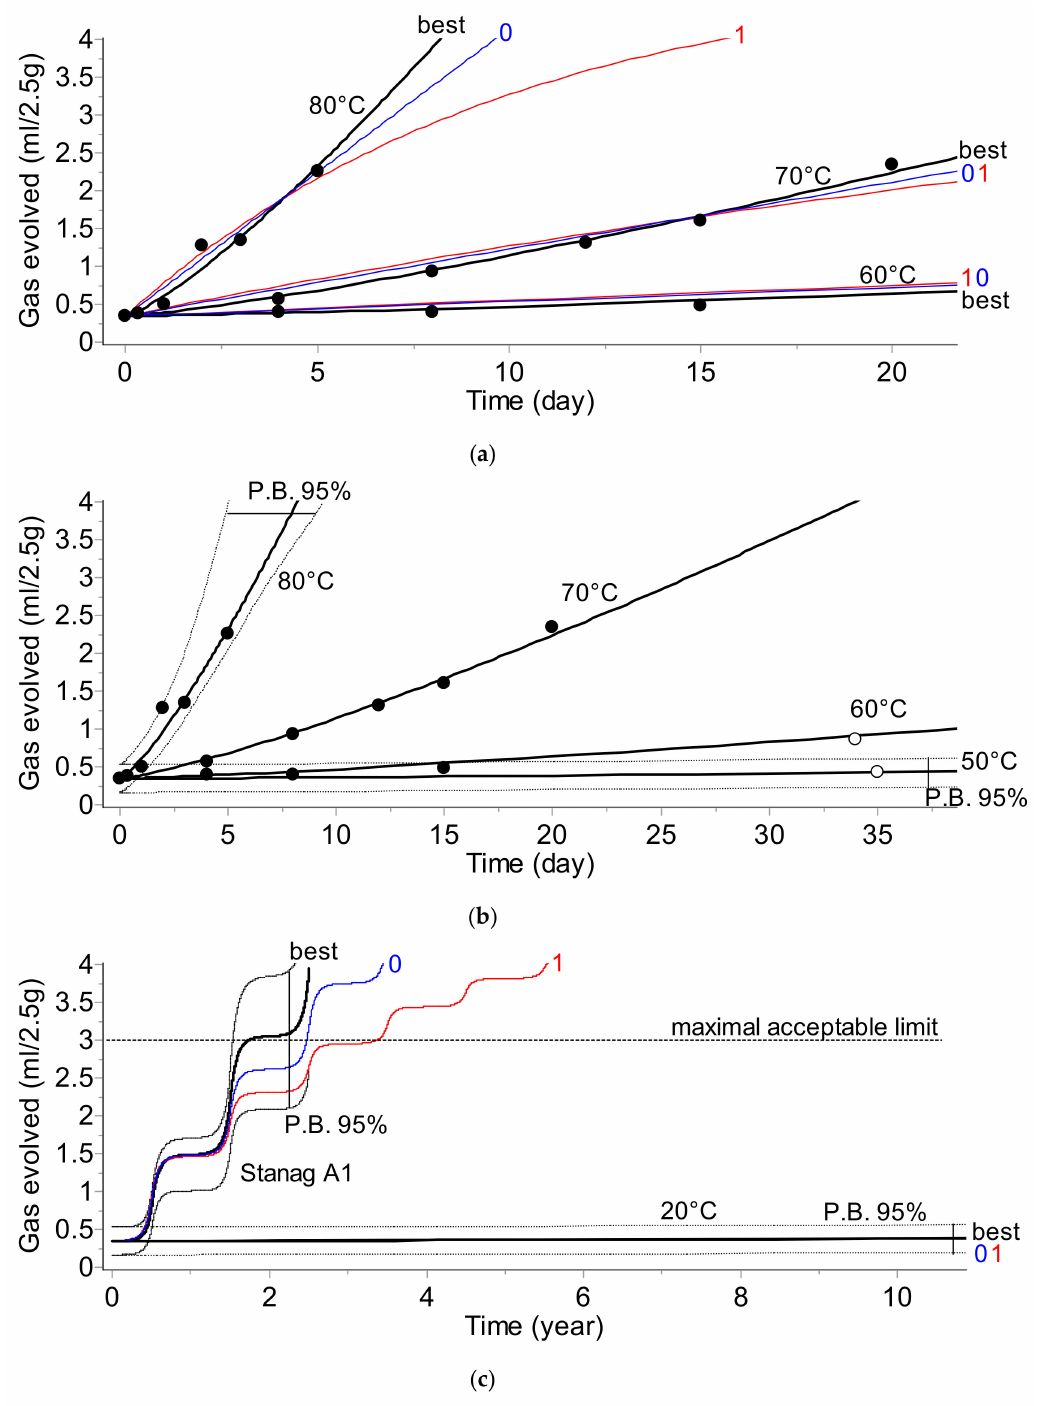
Figure 2. Gas evolution (VST) test. The plots present: ( a ) The fit of experimental data by the best (bold), 0th, and 1st order models. ( b ) Prediction of the long-term reaction course for temperatures of 80, 70, 60, and 50 ◦ C (predictions are verified by experimental data marked as empty circles). ( c ) 10-year predictions for 20 ◦ C and climate category STANAG